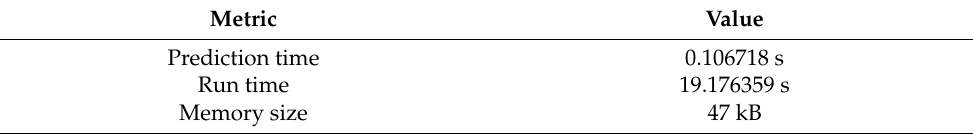
Table 9. Other metrics recorded (multiclass classification) for the DT-based anomaly